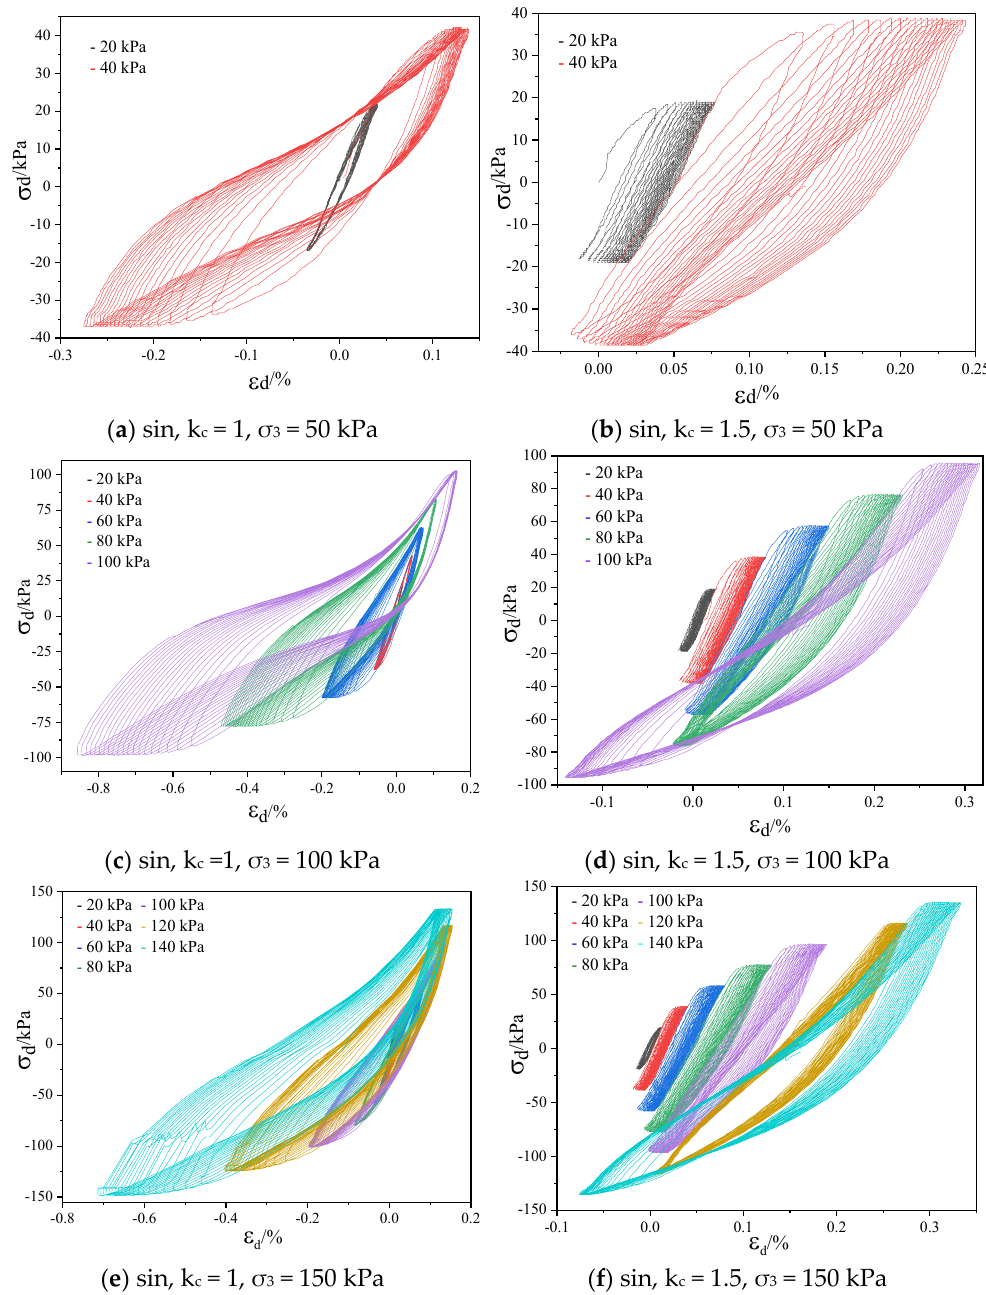
Figure 9. Effect of consolidation ratio on hysteretic curve. Under the same dynamic stress level, the strain of the specimen response under bias consolidation was small. To be specific, in the hysteretic curve under the confining pres- sure of 100 kPa, when the dynamic stress amplitude was 60 kPa, the strain amplitude of the isobaric consolidation was 0.175%, and the strain amplitude of the bias consolidation was 0.138%. When the dynamic stress amplitude was 80 kPa, the strain amplitude of the isobaric consolidation was 0.47%, and that of the eccentric consolidation was 0.231%. When the dynamic stress amplitude was 100 kPa, the strain amplitude of the isobaric con- solidation was 0.858%, and that of the anisotropic consolidation was 0.316%, showing that the method of bias consolidation inhibited strain development of the coarse-grained soil specimens relatively well with the increasing stress levels.